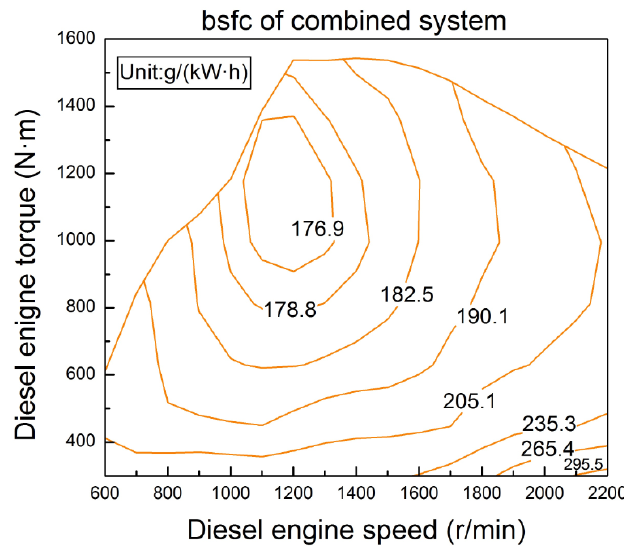
Figure 14. BSFC of the combined system under engine various operating